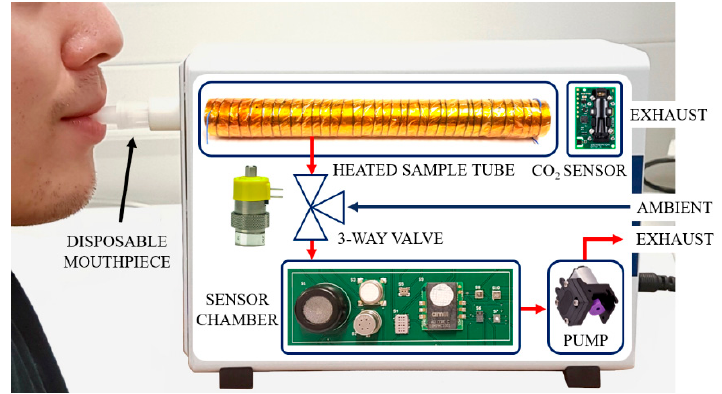
Figure 3. Internal system view of the WOLF Breath E-nose.